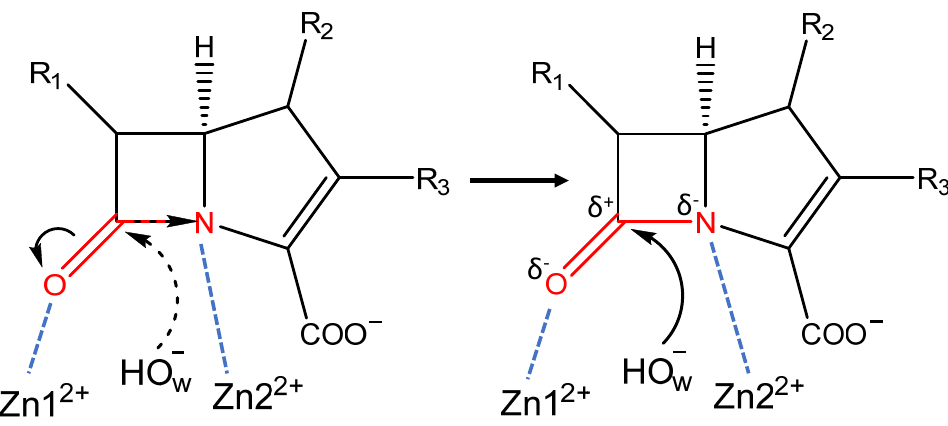
Figure 2. Scheme of the activation of the carbapenem by metallo- β -lactamases L1 and NDM-1. Black arrows on the left part of the figure shows the direction of charge concentration shift; on the right side, the nucleophilic attack of the activated carbonyl carbon by O w H − is shown. Black dashed arrow shows the nucleophilic attack on the non-activated carbonyl carbon, blue dashed lines show coordination bonds of zinc ions with the substrate in the active site. Red molecular fragment polarizes in the active site, thus activating the carbonyl carbon atom.